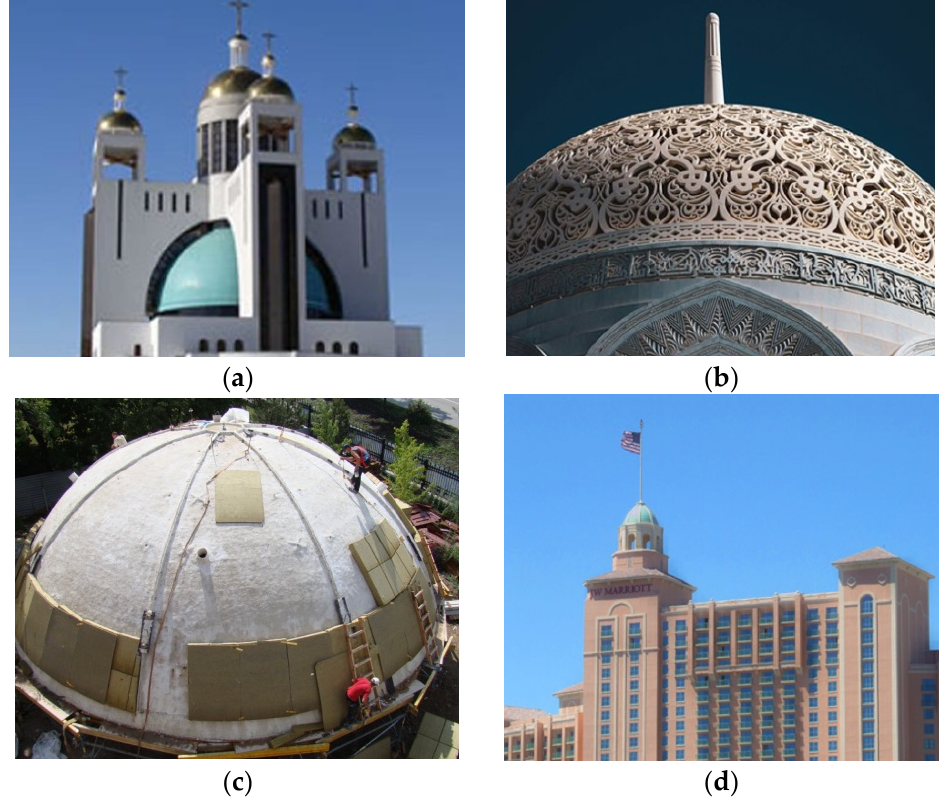
Figure 30. ( a ) Cathedral of the Resurrection of Jesus Christ, Kyiv, Ukraine [125]; ( b ) Mohammed Al-Ameen Mosque, Muscat, Oman [126]; ( c ) church dome, Ukraine [127]; ( d ) Marriott—Grande Lakes Resort, Orlando, USA [128].